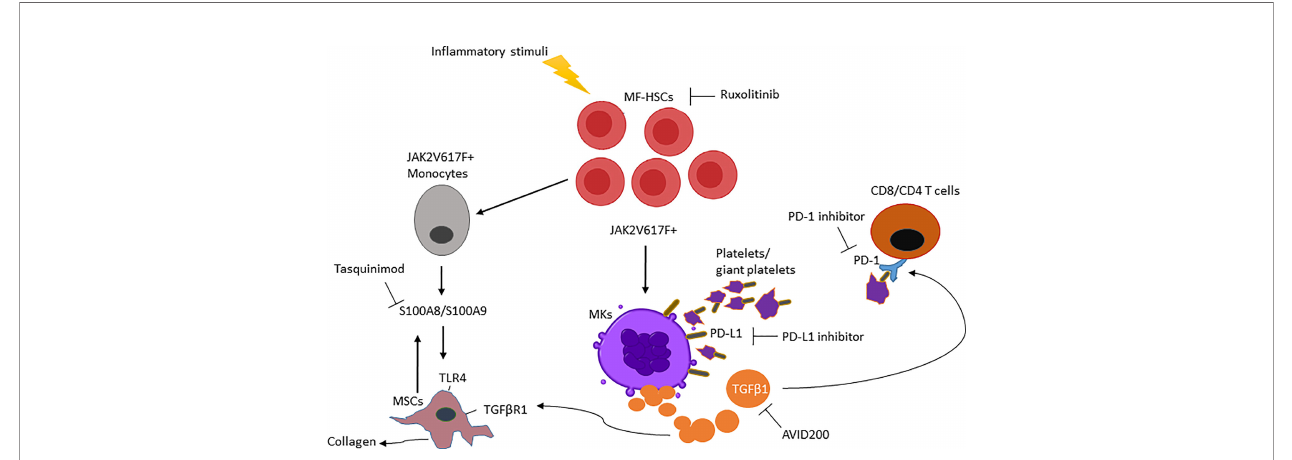
FIGURE 1 | Main mediators in myelo fi brosis and combination therapies are required to enhance the MF-modifying potential of ruxolitinib. (i) Clonal MF-HSCs events are favored by in fl ammatory stimuli. (ii) MF-HSCs will further differentiate into MKs and monocytes producing increased TGF b 1 and S100A8/S100A9 that modify the BM microenvironment and activate TGF b R1/TLR4 from MSCs. (iii) TGF b 1 ligand increases PD-1 expression on T cells and, PD-L1 expressed on the platelets interact with PD-1 on T cells causing its exhaustion. (iiv) As a result, the interruption of these MF-HSC mediators by a single pharmacologic inhibitor will be ineffective in reducing MF-HSCs unless used in combination